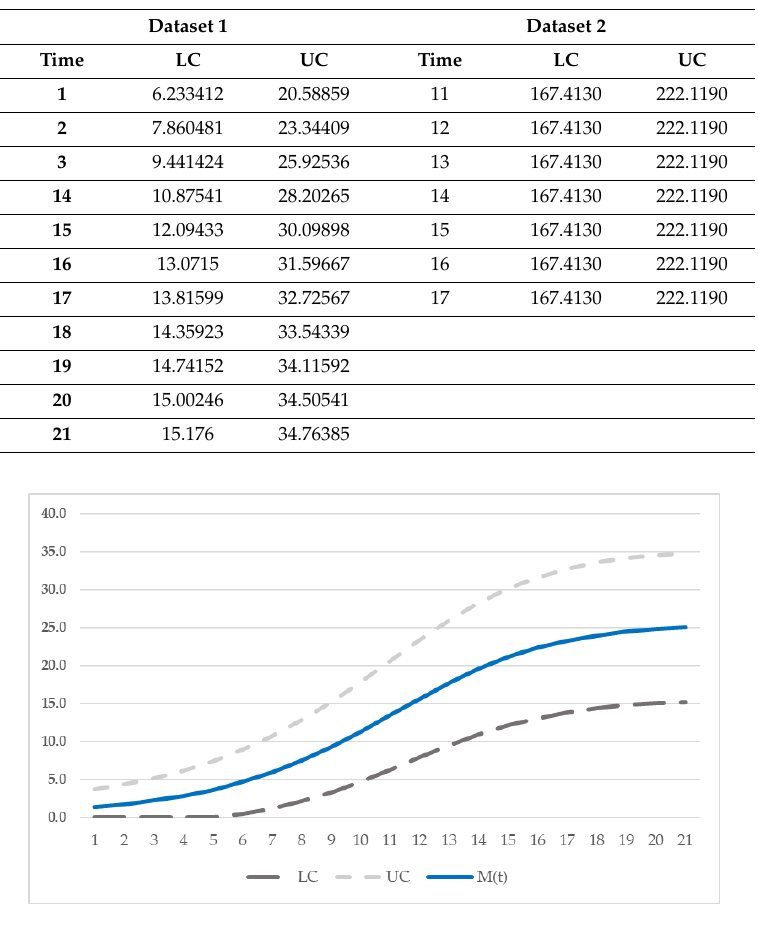
Figure 7. Confidence interval of proposed model for dataset 1.